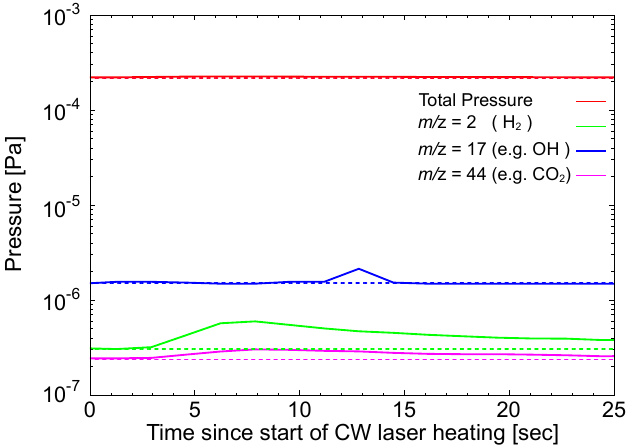
Figure 3. Quadrupole mass spectrometer (QMS) measurement of the partial pressures of different molecular masses as a function of time after the start of laser heating, shown with solid lines. Dashed lines represent the initial pressures before CW laser heating.